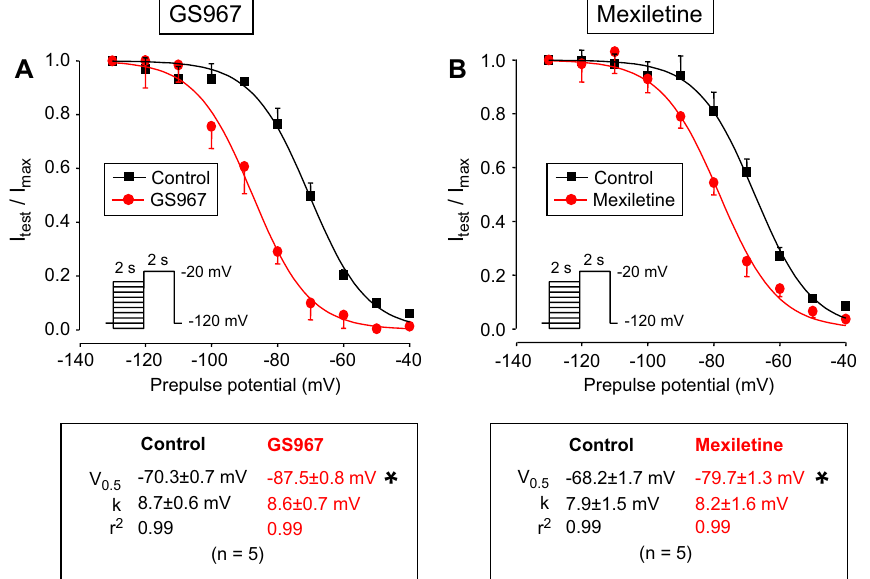
Figure 2. Effects of 1 µM GS967 ( A ) and 40 µM mexiletine ( B ) on the voltage dependence of steady-state inactivation of I NaL , determined using a conventional prepulse-protocol presented in the insets. 2 s long prepulses, ranging from –130 to −40 mV were followed by a test pulse clamped to −20 mV for 2 s. Each I